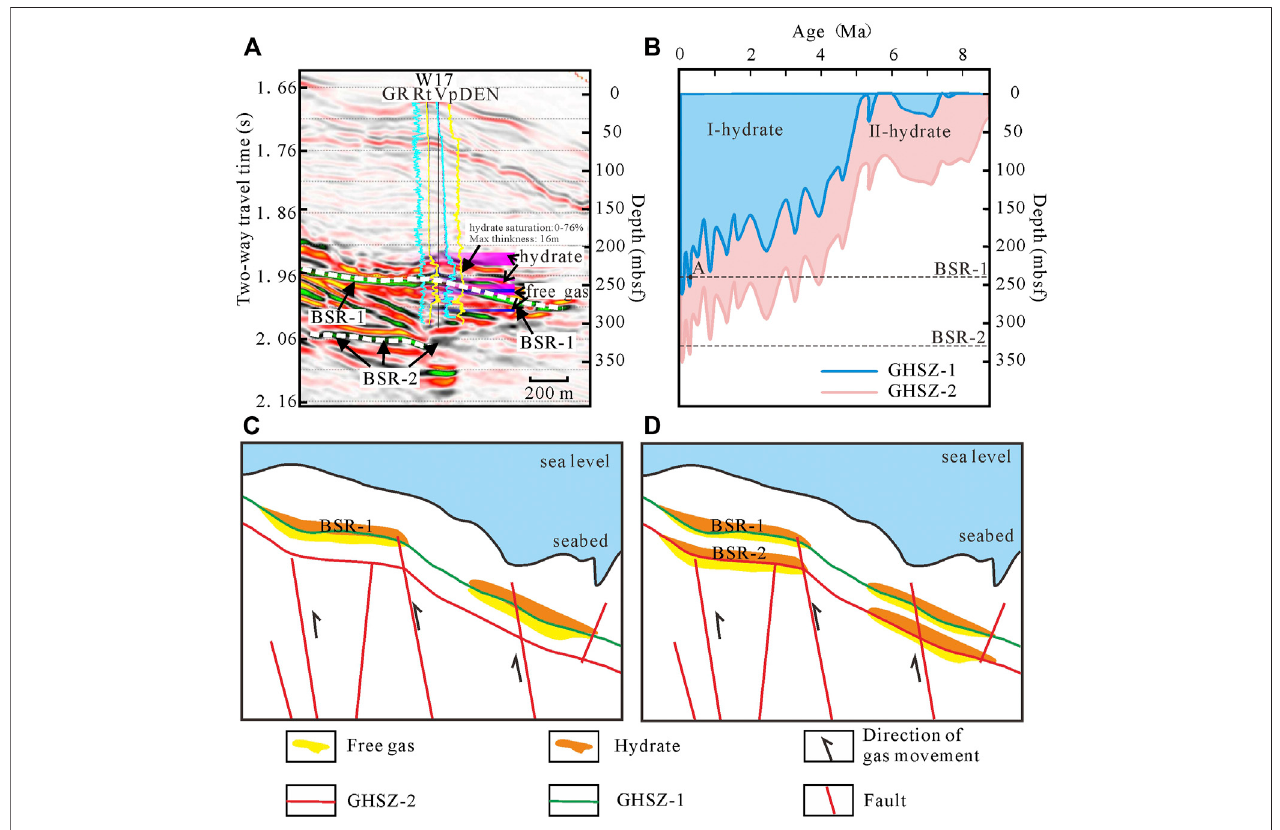
FIGURE7|(A) Seismicre fl ectioncharacteristicsofdoubleBSRsacrosssiteW17(modi fi edfromQianetal.,2018). (B) ThethicknessevolutionoftheGHSZatW17 and the possible depth range of type I and type II hydrate formation since 8.2 Ma (C),(D) Double BSRs pattern based on differences in gas source and composition (taking site W17 as an example).